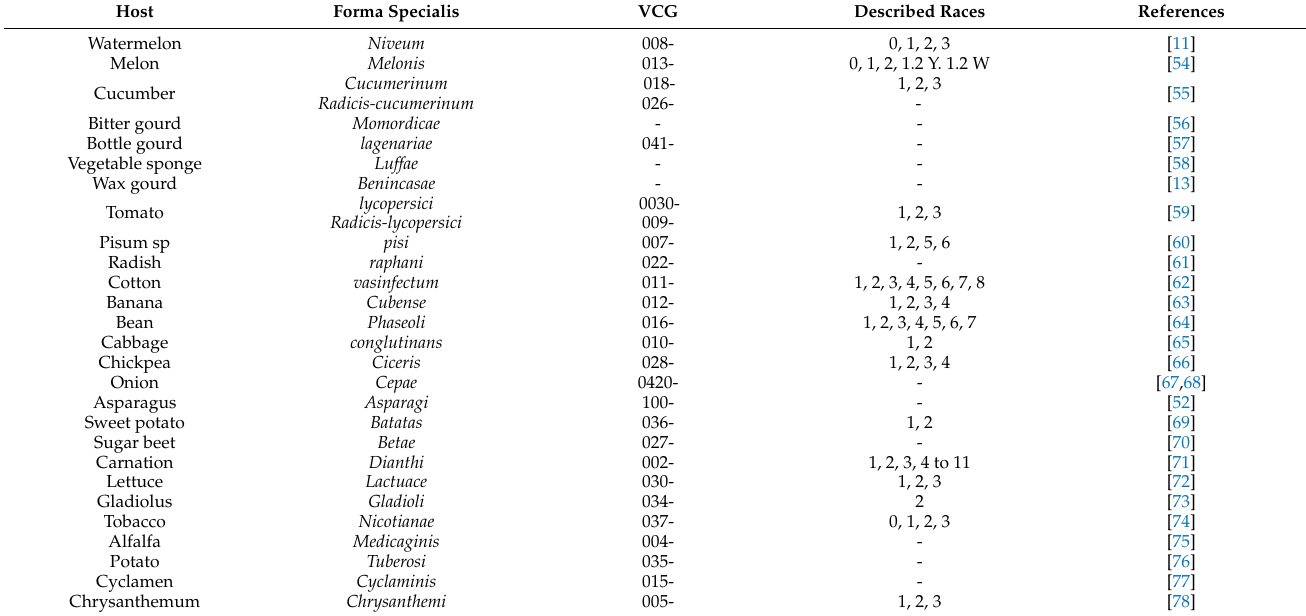
Table 2. Vegetative compatibility groups, formae speciales, and several races of Fo responsible for vascular wilt disease in many important